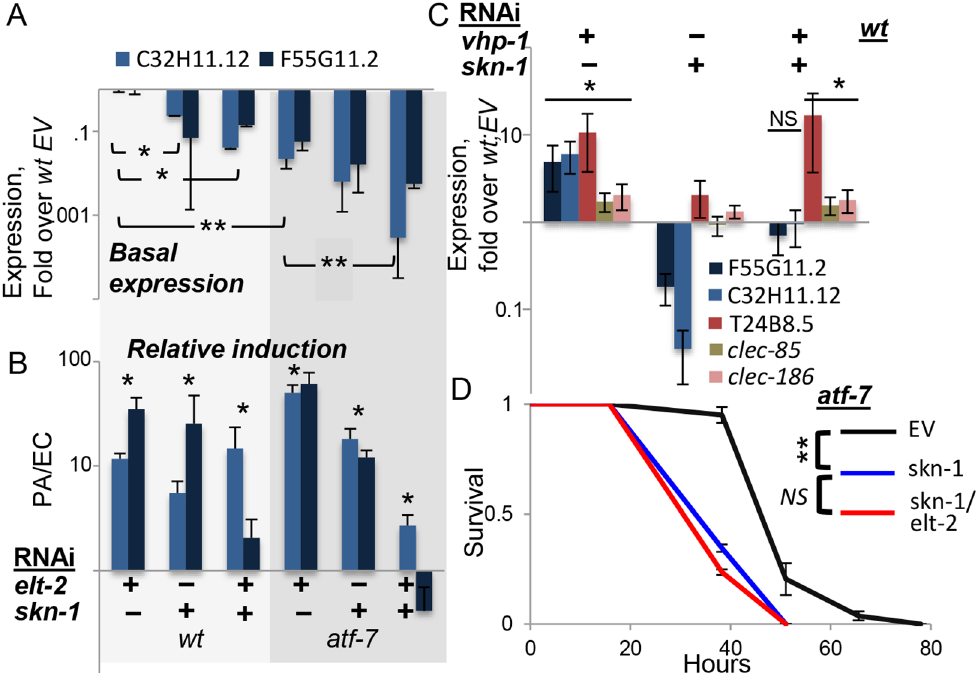
Fig 4. skn-1 co-regulates gene expression with atf-7 and elt-2 . A-C , Gene expression (log scale) in wildtype or atf-7(qd22qd130) animals fed with designated RNAi ’ s during development. Averages ± SDs for two independent experiments (or three, in C), with * p < 0.05 and ** p < 0.0005 (t-test) for differences between groups joined by line (A), or between marked groups and their respective references (B). A , basal expression following development knock-down, with values and statistics relative to values in wt;EV, not shown. B , similar RNAi treatments as in A, followed by exposure to P . aeruginosa (PA). Responses to PA are shown as fold over basal expression in similarly-treated worms grown on E . coli (EC). C , basal expression following development knock-down; note effective induction of T24B8.5, clec-85 and clec-186 by vhp-1 RNAi in the context of a double knock-down. D , Survival curves for atf-7 (qd22qd130) animals fed with designated RNAi ’ s during development, followed by infection; averages ± SDs for three plates (N = 83 – 90 per group).